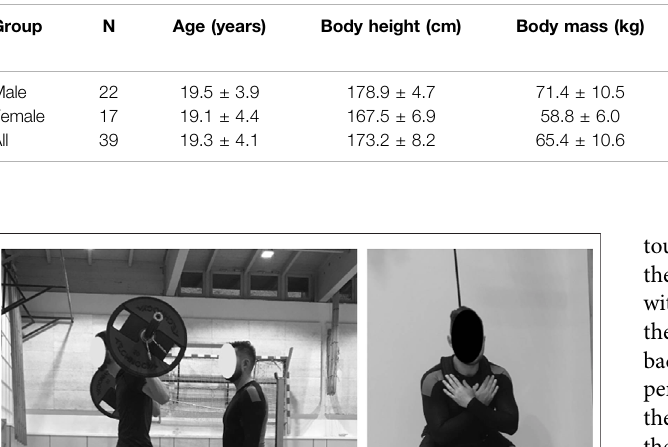
Frontiers in Physiology |